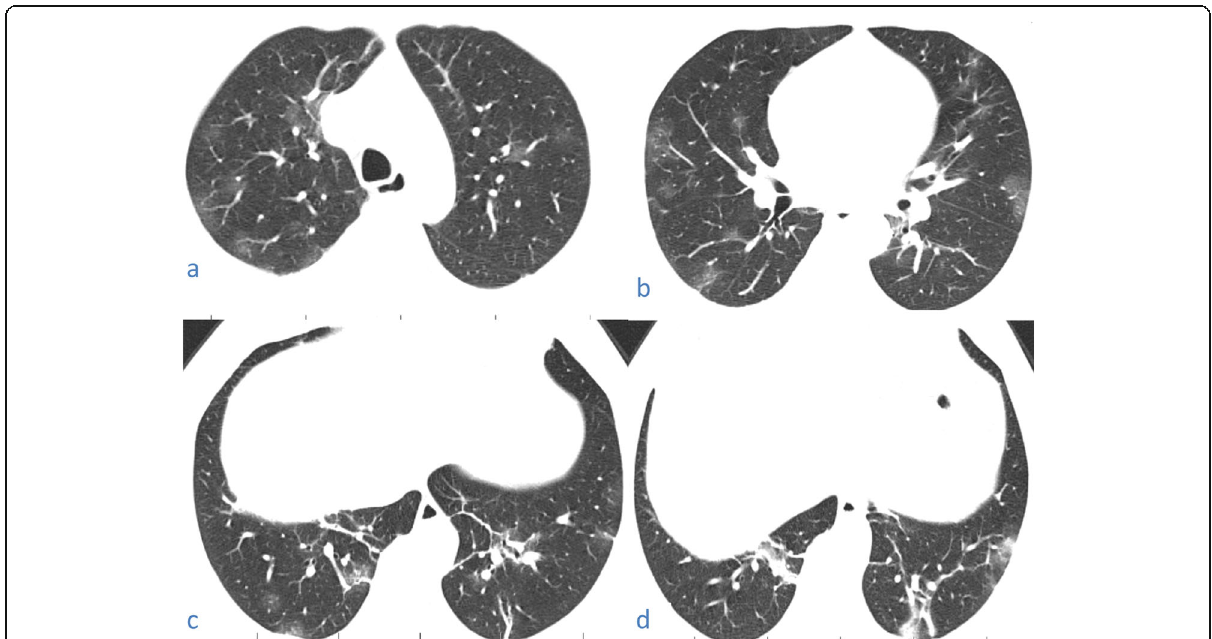
Fig. 13 A 40-year-old male patient with COVID-19. CT chest axial images ( a ) and ( b ) show subpleural and patchy ground glass opacities with vascular thickening, ( c ) and ( d ) show bilateral basal subpleural areas of ground glass opacities and consolidation with fibrous stripes, architectural distortion, spider web opacities, and perilobular thickening